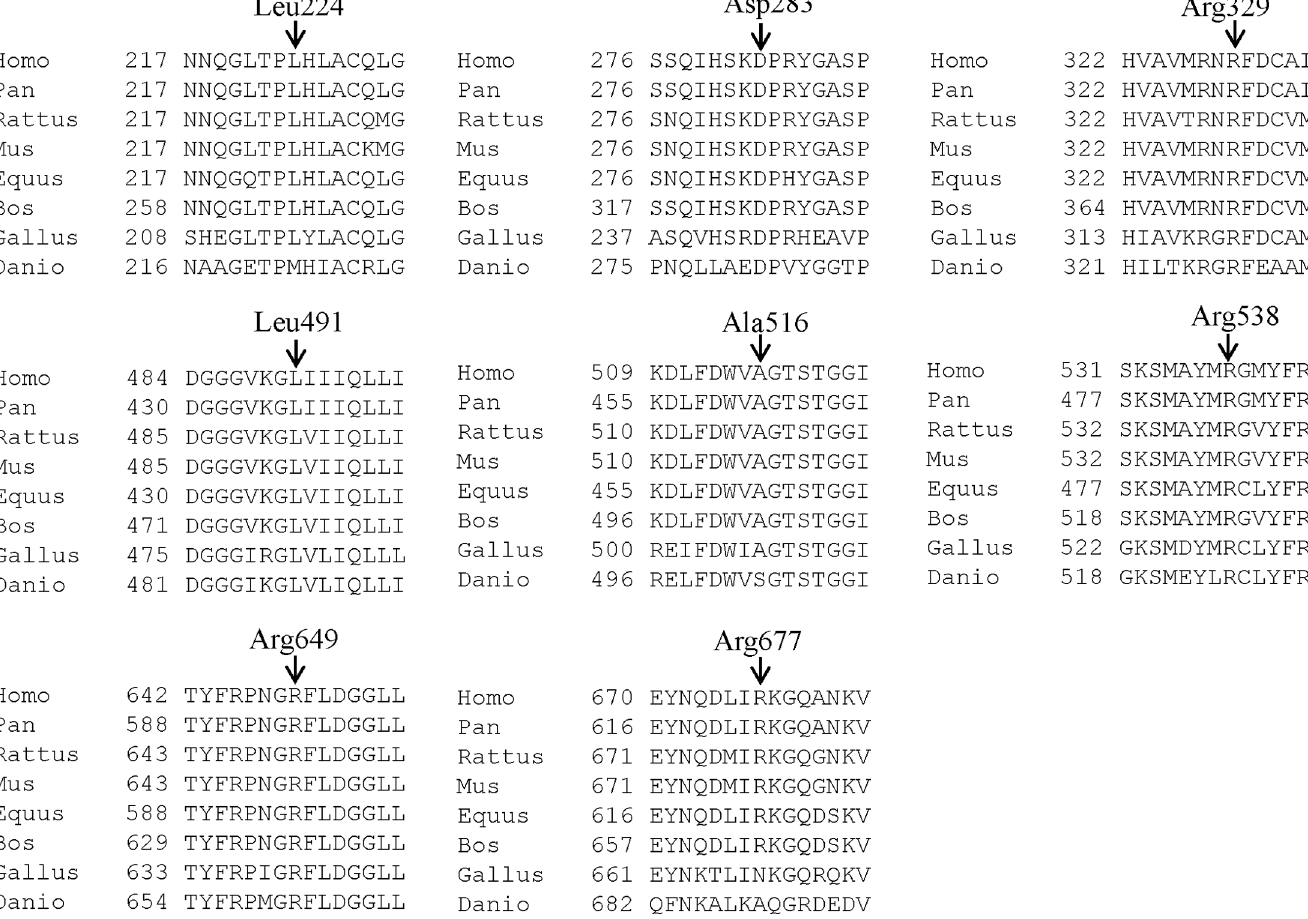
Fig 3. Conservation of amino acid residues across different species in PLA2G6. Arrows mark the conservation of amino acid residues Leu224, Asp283, Arg329, Leu491, Ala516, Arg538, Arg649 and Arg677 across different species. The number refers to the position of amino acid